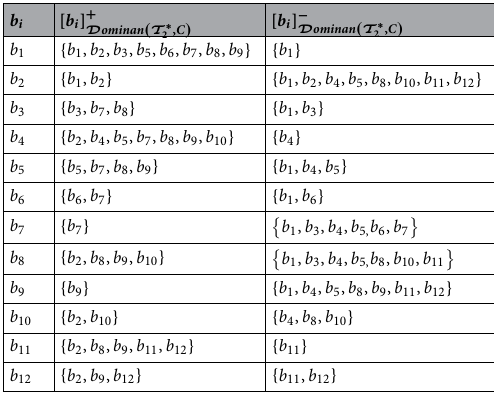
[ b i ] − D ominan ( T ∗ C ) 2 ,